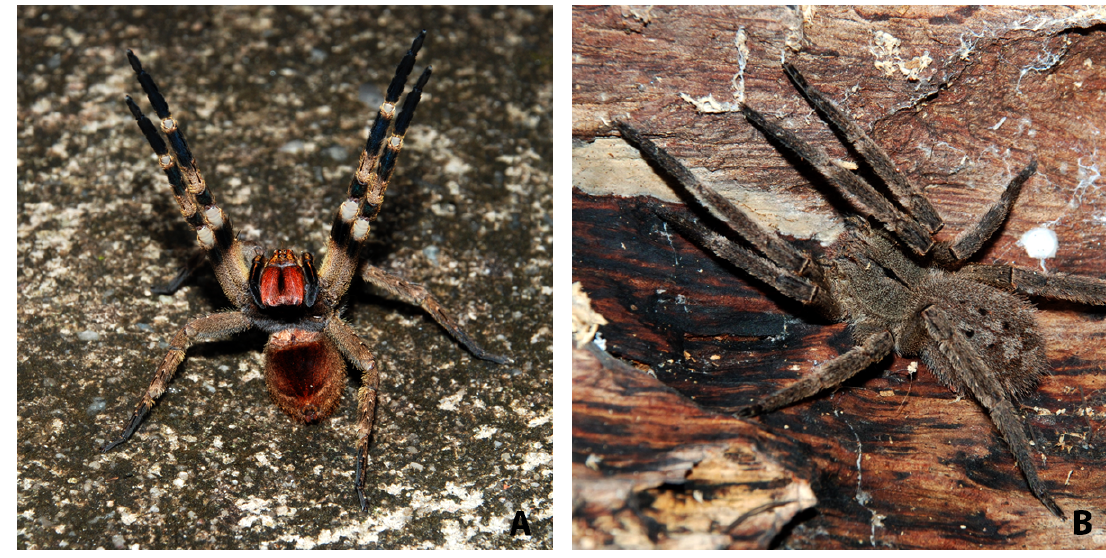
Figure 1. Phoneutria nigriventer spider. (A) Frontal view in its defensive position and (B) back view of adult species found in the central region of Minas Gerais state, Brazil. Photo by Pedro H. Martins, personal archives (reproduced with